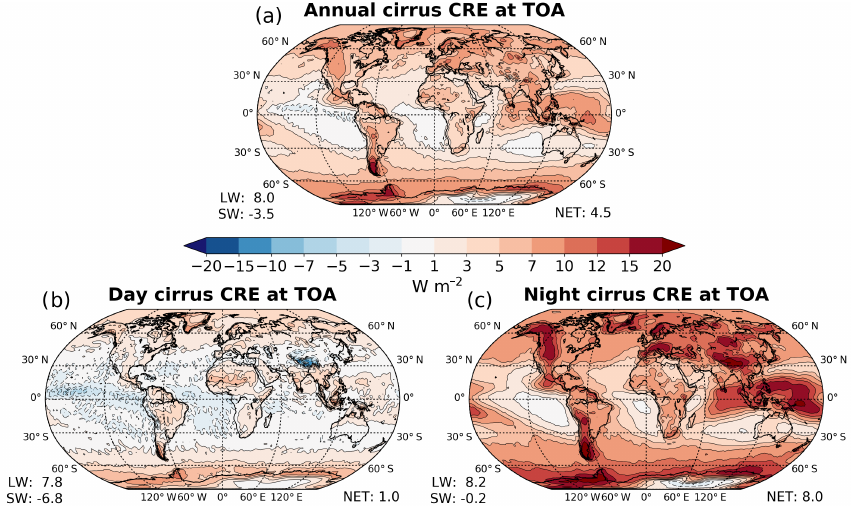
Figure 3. Five-year all-sky TOA anomalies of net cirrus cloud radiative effects (cirrus CRE) for the reference (unseeded) fixed SST simulation in annual average (a) and when computed only during day (b) and night (c) . The day/night definition is based on the solar zenith angle, where day includes all grid boxes with the sun above the horizon. Panel (a) is reproduced with slight modifications from Gasparini and Lohmann